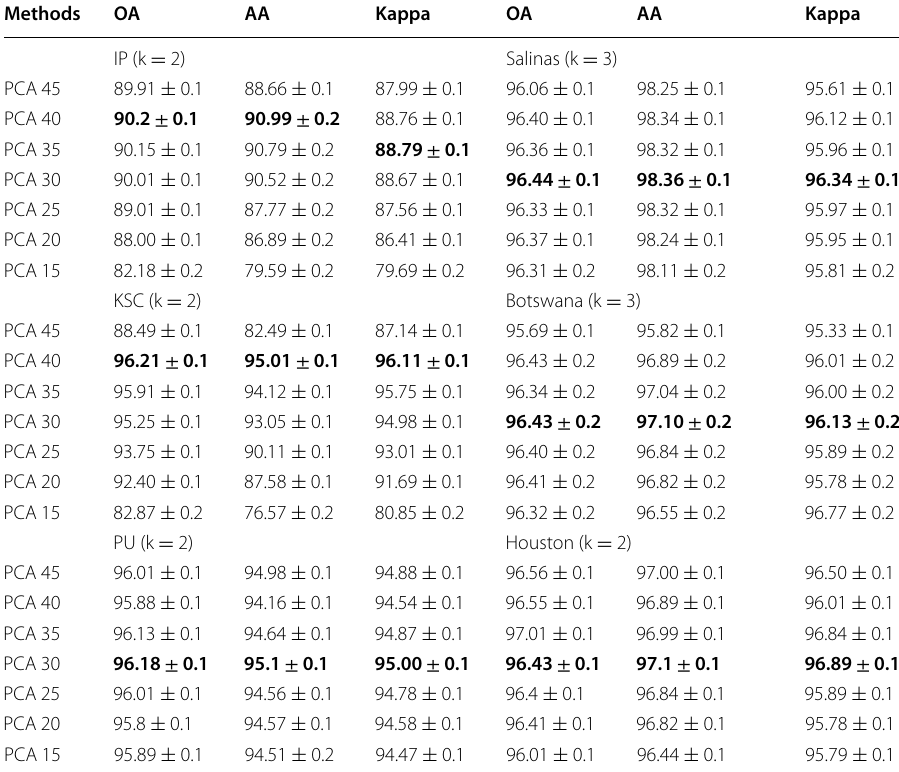
Highest performing values are highlighted in bold